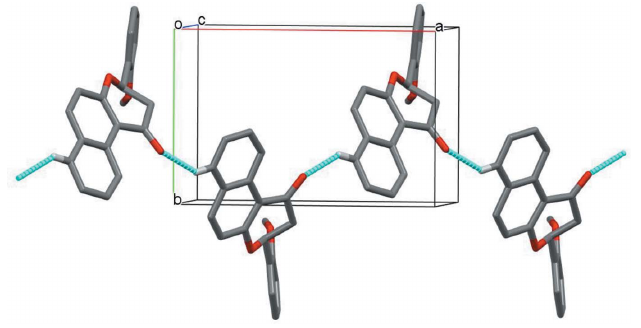
Figure 2 Part of the crystal structure of the title compound, showing the weak C— H (cid:4)(cid:4)(cid:4) O hydrogen bonds as blue lines. H atoms not involved in these interactions have been omitted for clarity.